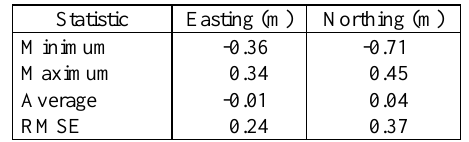
Table 3. Statistics of the errors found in object coordinates obtained by